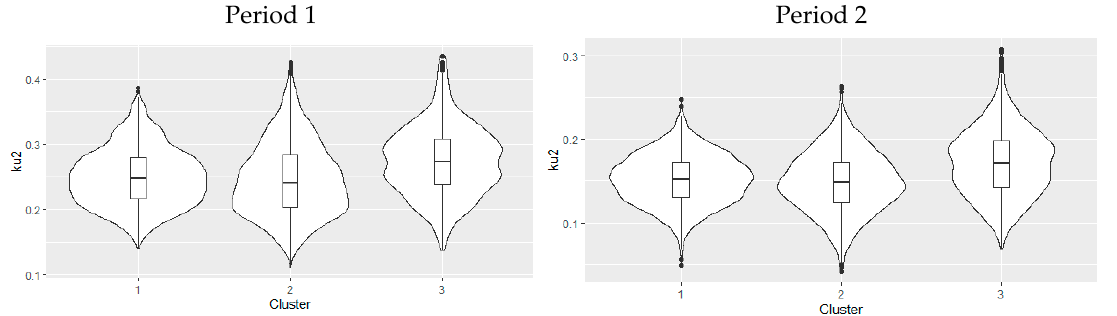
Figure 11. Violin plots of voltage unbalance factor k u2 comparing clusters for Period 1 and Period 2.